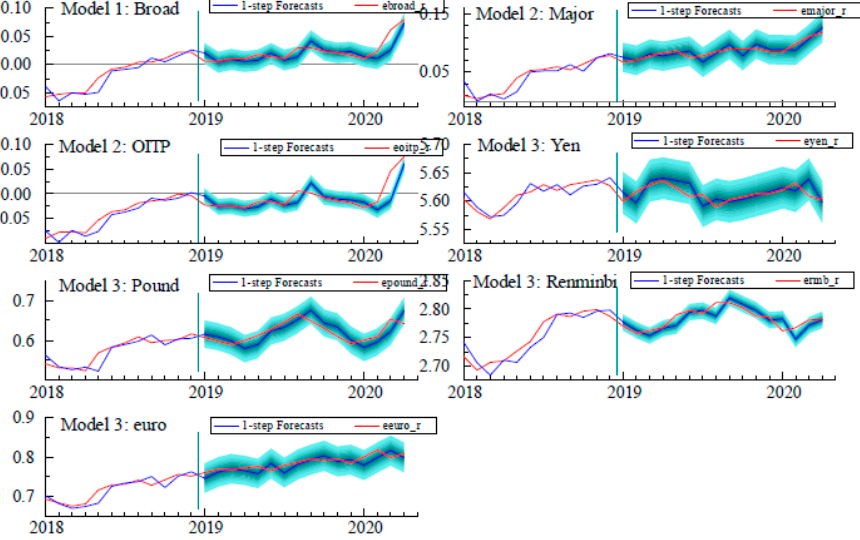
Figure 10. Out-of-sample l-step ahead forecasts for exchange rates. Sensitivity to Model Specification.